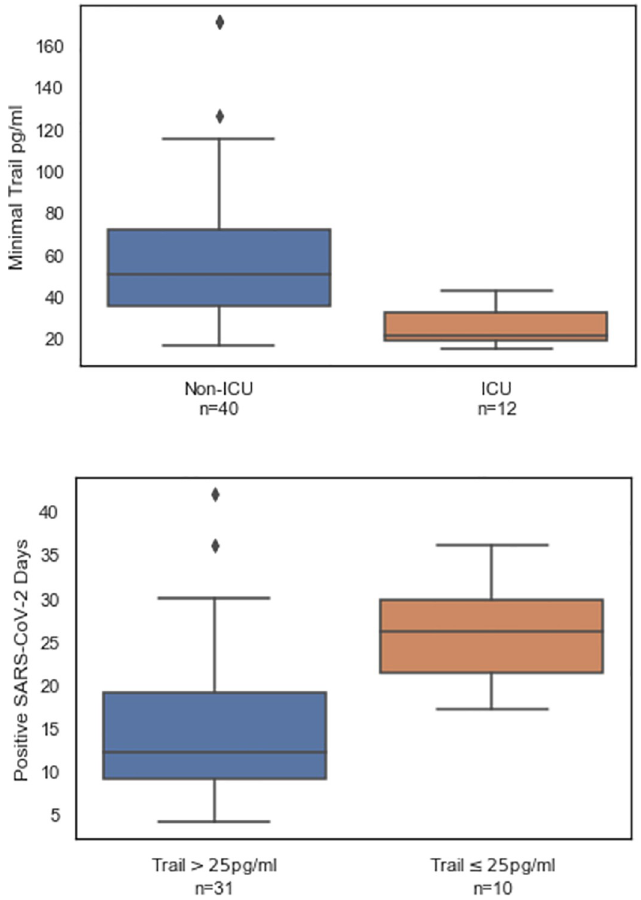
Fig 6. TRAIL levels correlate with ICU admission (upper panel) and viral positivity (lower panel). TRAIL was measured at multiple time points during hospitalization. At least one TRAIL measurement exceeding 25 pg/mL in a given day was sufficient to classify the day as exceeding 25 pg/mL. The bottom, middle and top box lines indicate the 25%, 50%, and 75% percentiles, respectively. The whiskers indicate the 25% and 75% quartile plus 1.5 times the interquartile